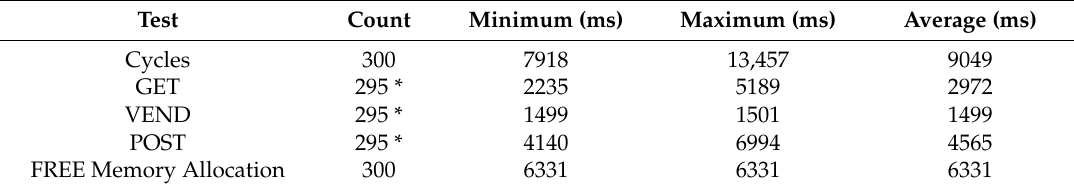
Table 2. Performance test